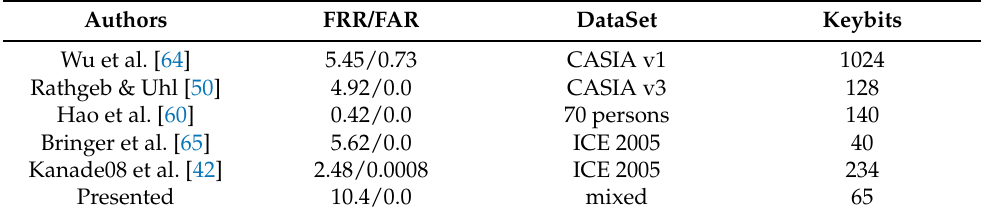
Table 7. The results of iris biometric